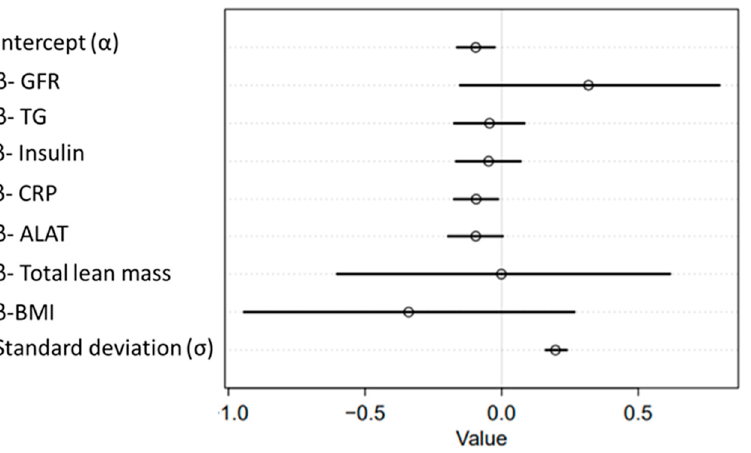
Figure 5. Multiple linear regression analysis between osteocalcin (dependent) and metabolic, inflammatory, and body composition variables (independent). X -axis, confidence intervals (CIs) of the strength of correlation to osteocalcin change; y -axis, parameters of the regression: slope coefficients of each variable (beta), intercept (alpha), and standard deviation (sigma). Considering all slope coefficients, beta-CRP is the only parameter with a completely negative CI, indicating that CRP level change is associated with OC level change in lifestyle-induced weight loss. All other slope CIs range from negative to positive values, indicating that their variables alone cannot predict OC level change. TG, triglycerides; CRP, C-reactive protein; ALAT, alanine aminotransferase; BMI, body mass index; GFR, glomerular filtration rate.